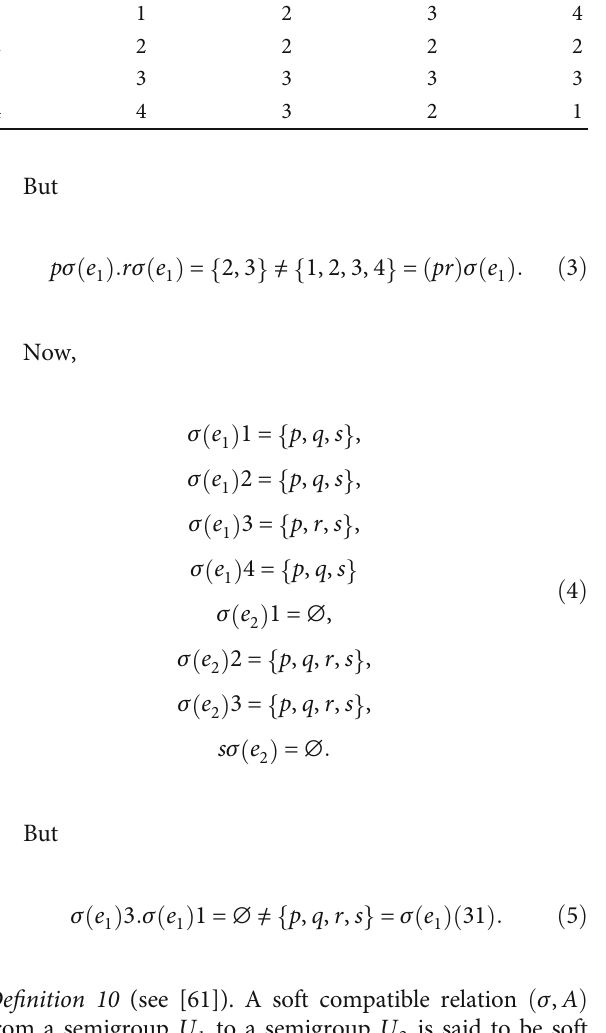
Table 3: Multiplication table for U